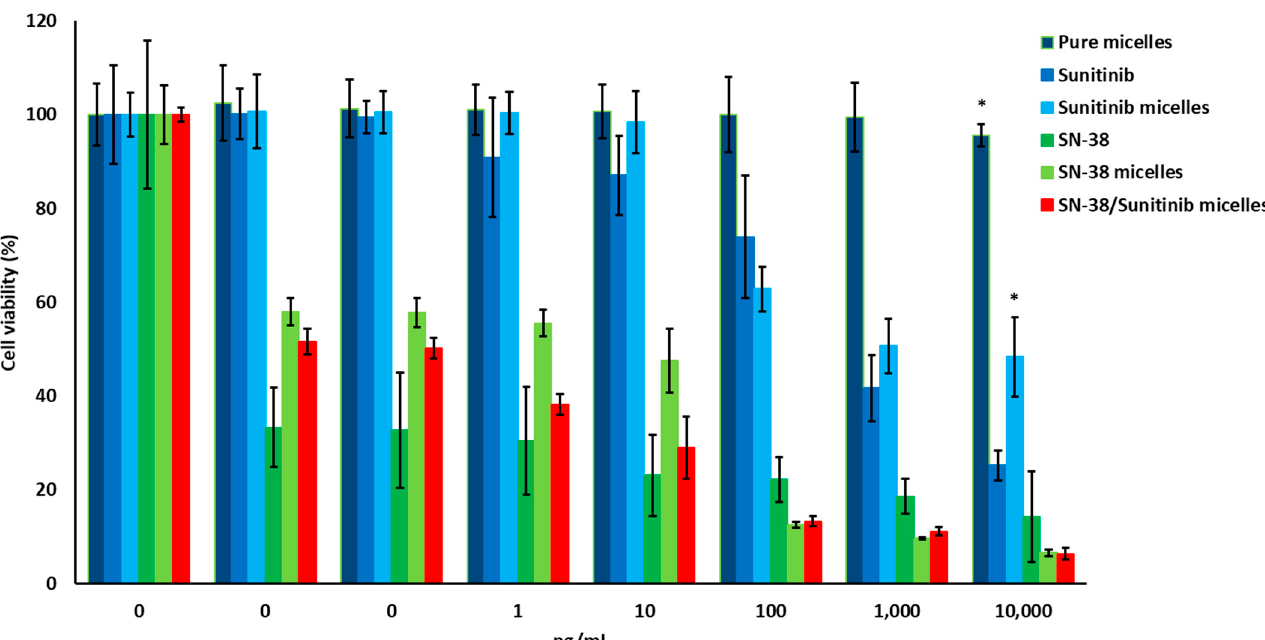
Figure 2. Cell viability at 72 h after treatment with SN-38/Sunitinib in SW-620 ( A ), HT-29 ( B ) and HCT-116 ( C ) cells. The data represent mean ± standard deviation. * means were significantly differ- ent from SW-620 ( p < 0.05). # means were significantly different from HT-29 ( p < 0.05).